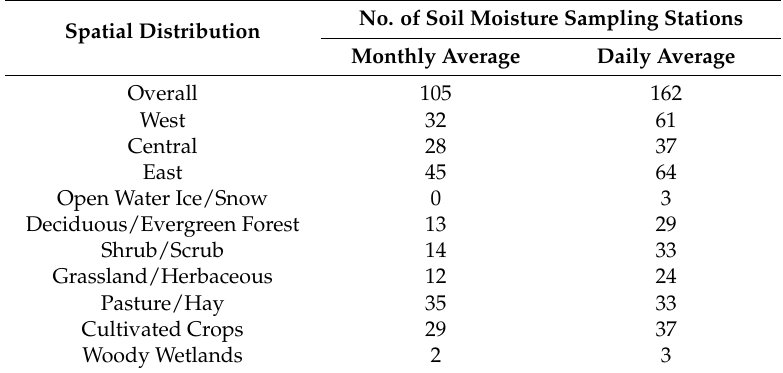
Table 1. The number of soil moisture sampling sites located in different spatial region and land cover types across the contiguous U.S. for acquiring monthly and daily average soil moisture data.